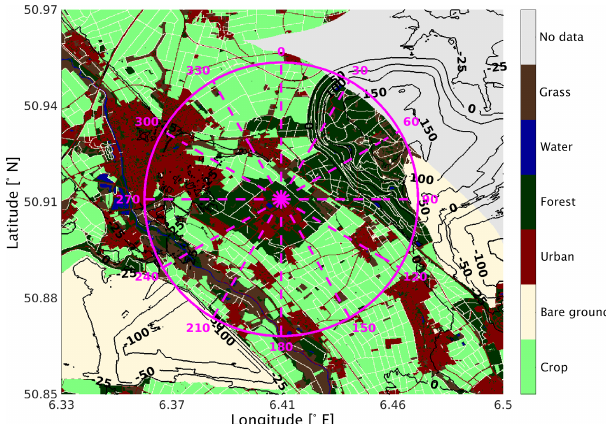
Figure 1. Simplified map (12km × 13km) of the land use classifi- cations described in Waldhoff et al. (2017) centered around JOYCE (see also Waldhoff and Lussem, 2016). The circle (4.3km radius) shows the crossing distance and azimuth angles of the MWR scans at the IWV scaling height of 2.5km. Contours refer to the height relative to JOYCE